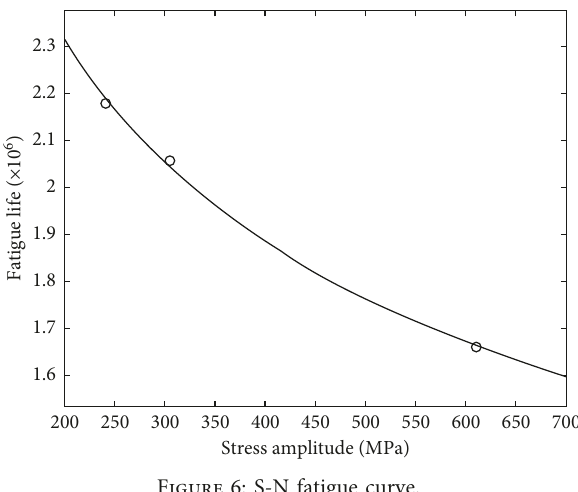
Figure 6: S-N fatigue curve.